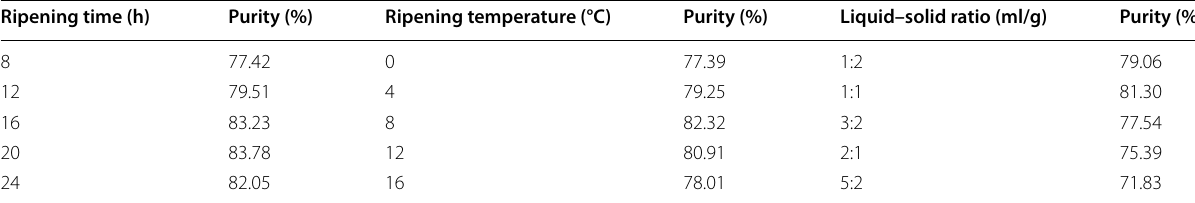
Table 4 The influence of time and temperature and liquid–solid ratio of precipitation Ripening time (h)